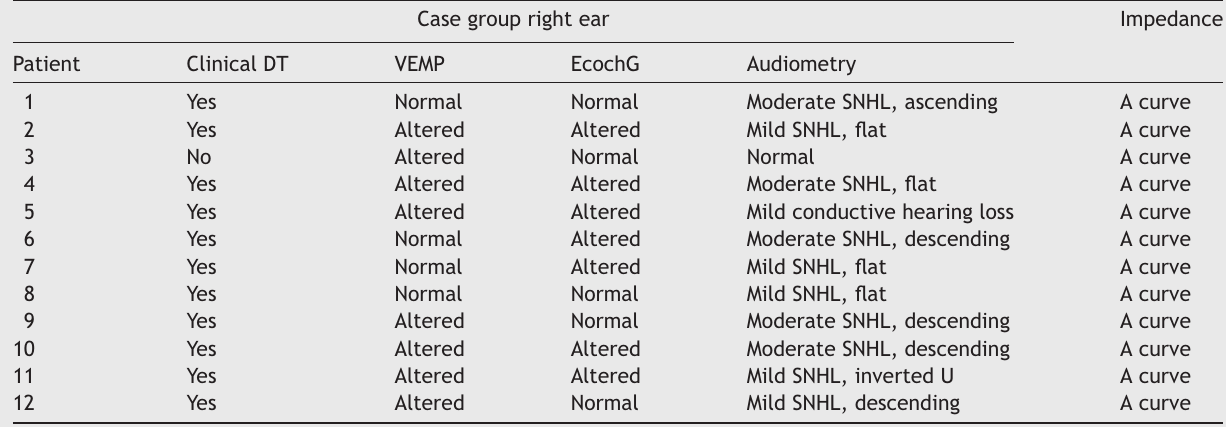
Individual results of the right ear in the case group.